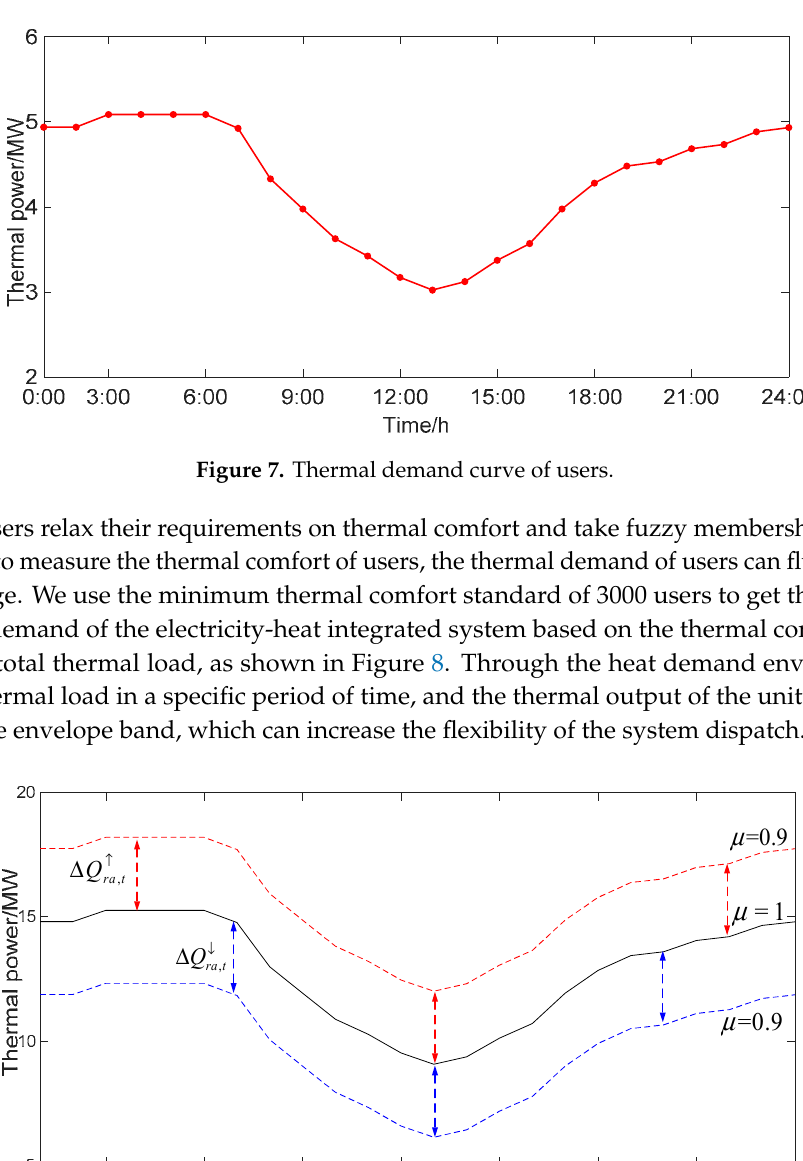
15 of 26 Figure 5. Topology diagram of the integrated energy system. The total power load is shown in Figure 6. Figure 6. The curve of power load.